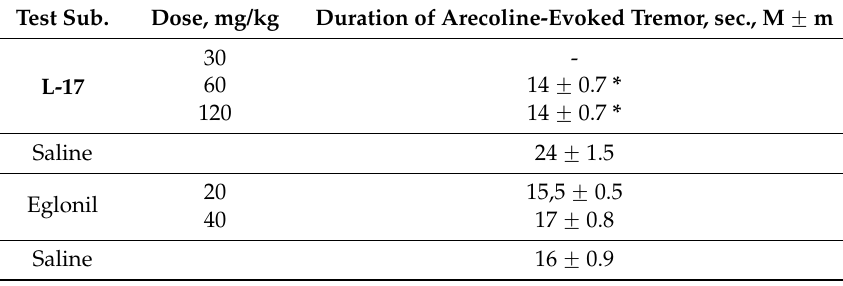
Table 6. The effect of compound L-17 on arecoline-evoked tremor. Test Sub. Dose, mg/kg Duration of Arecoline-Evoked Tremor, sec., M ˘ m